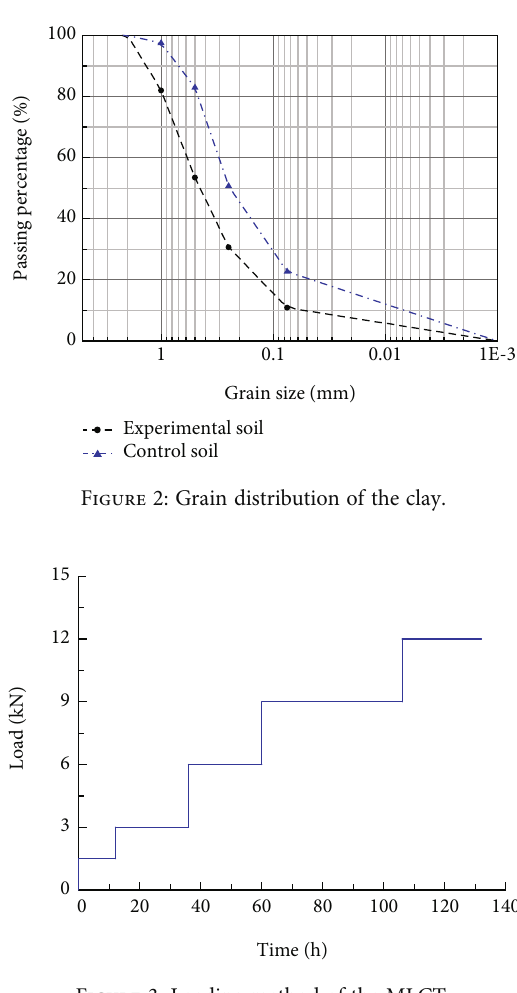
Figure 3: Loading method of the MLCT.